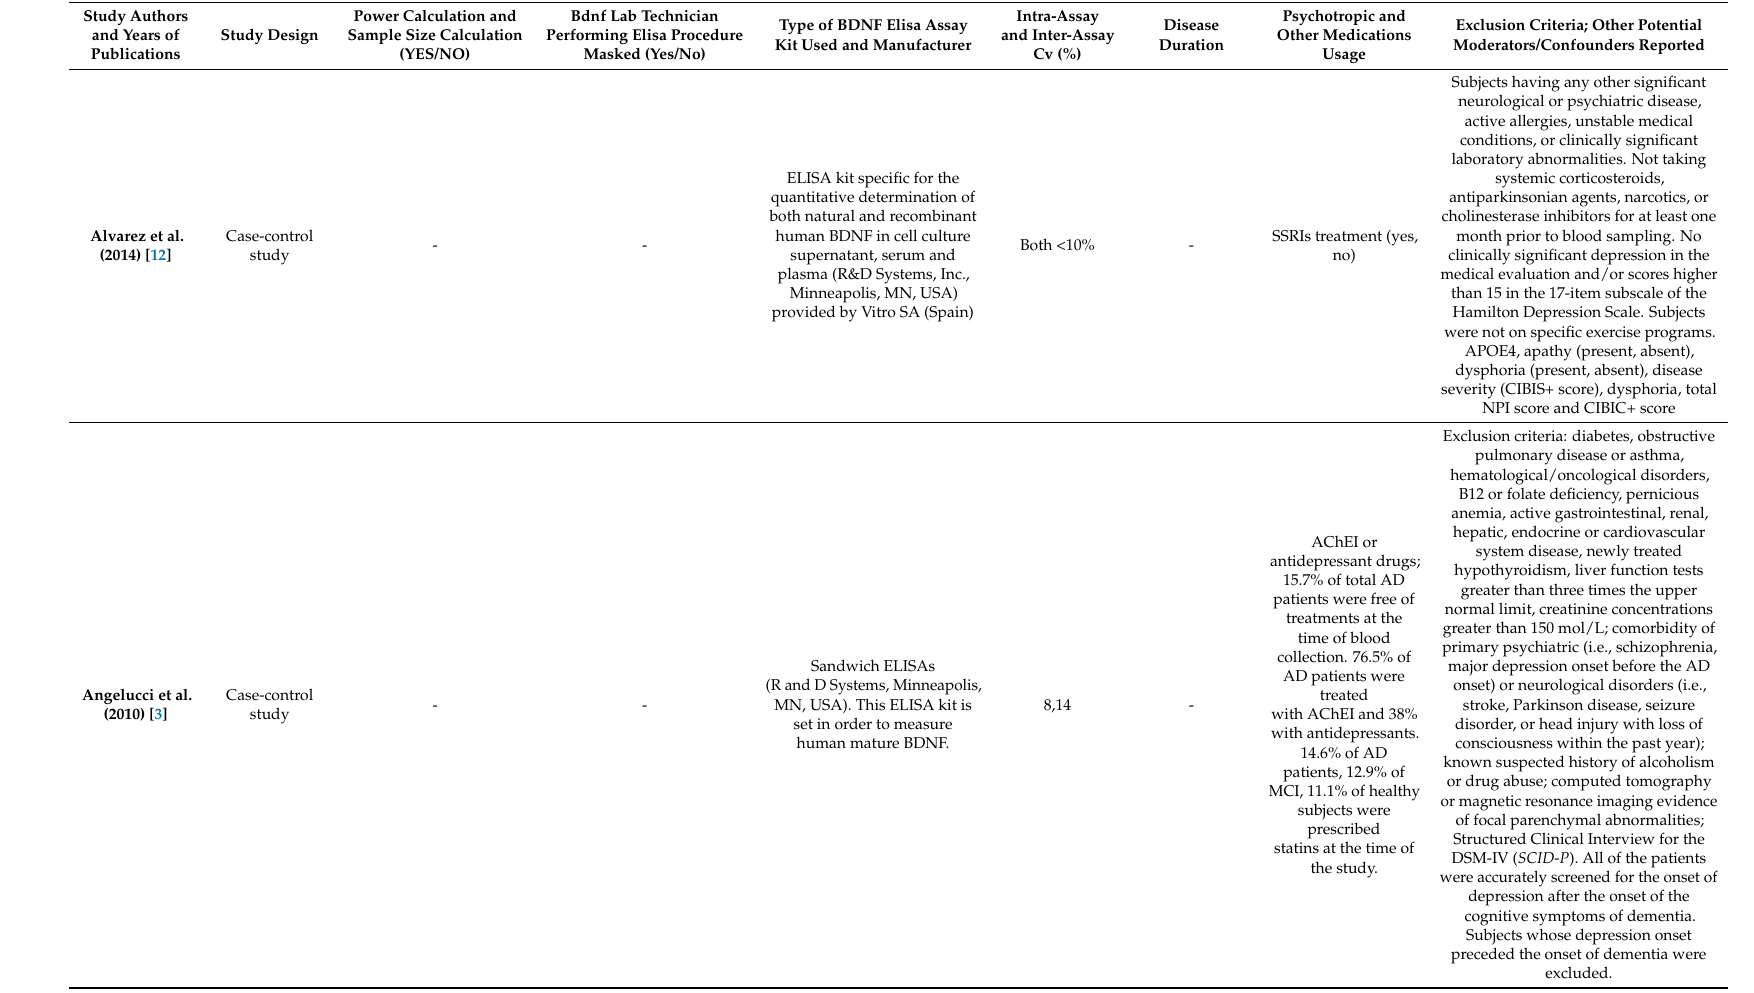
Table 2. Key methodological properties and laboratory